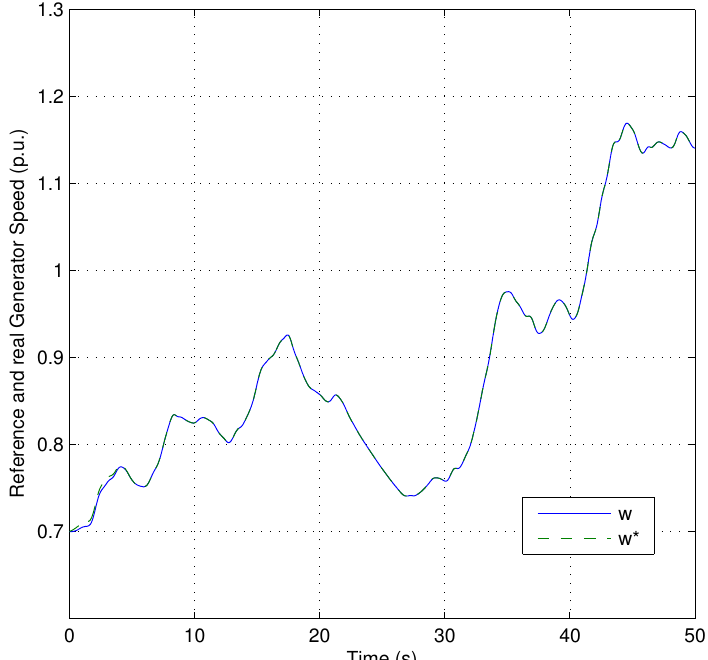
Figure 5. Reference and real rotor